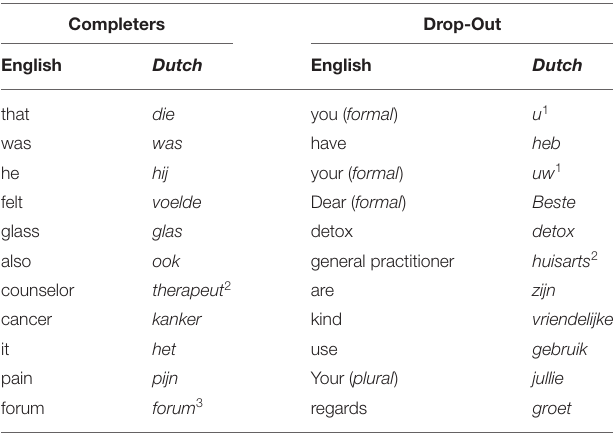
TABLE 5 | Confusion matrix for the models using the averaged LIWC scores. TABLE 3 | Top ten most commonly used words in the e-mails for those who completed the intervention, and for those who dropped out. Model Completers Drop-Out English Dutch